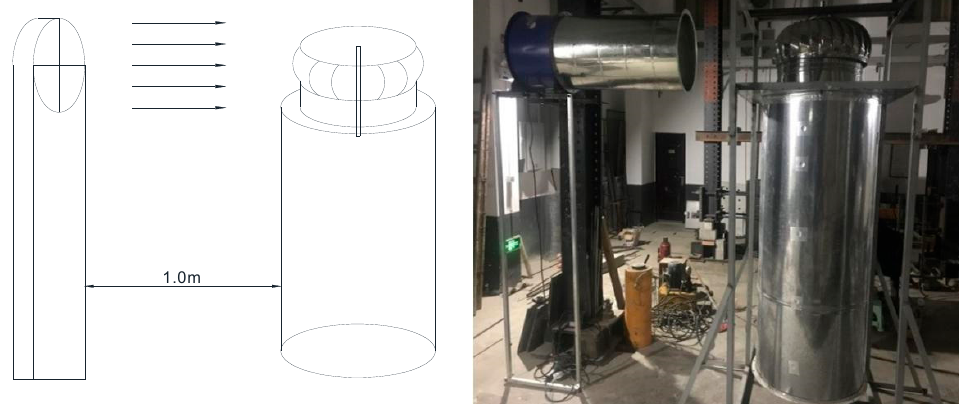
Figure 11. Experimental platform for the fan system.